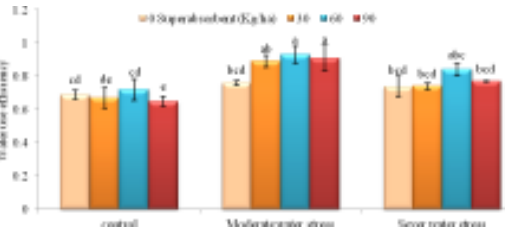
Fig. 2. Interaction effects of deficit irrigation and SAP rates on water use efficiency (kg m 3 ) of